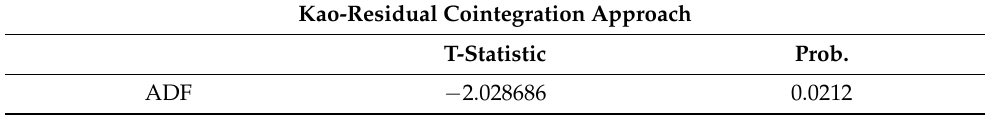
Table 6. Kao-Residual Cointegration Approach.